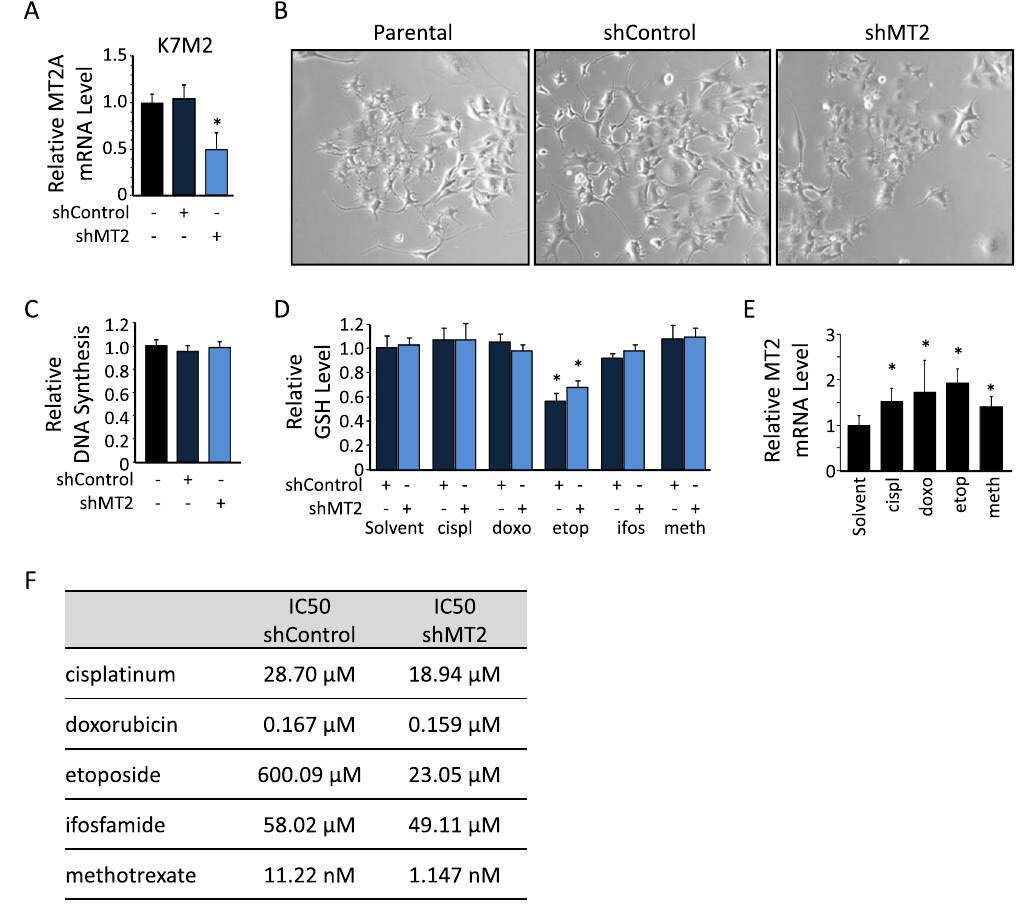
compared to treated mice bearing shControl cells-derived tumour: from − 40% with etoposide (p = 0.0028 vs . shControl); − 41% with ifosfamide (p = 0.0058); − 58% with doxorubicin (p = 0.0033) to − 87% with cisplatinum (p < 0.0001).